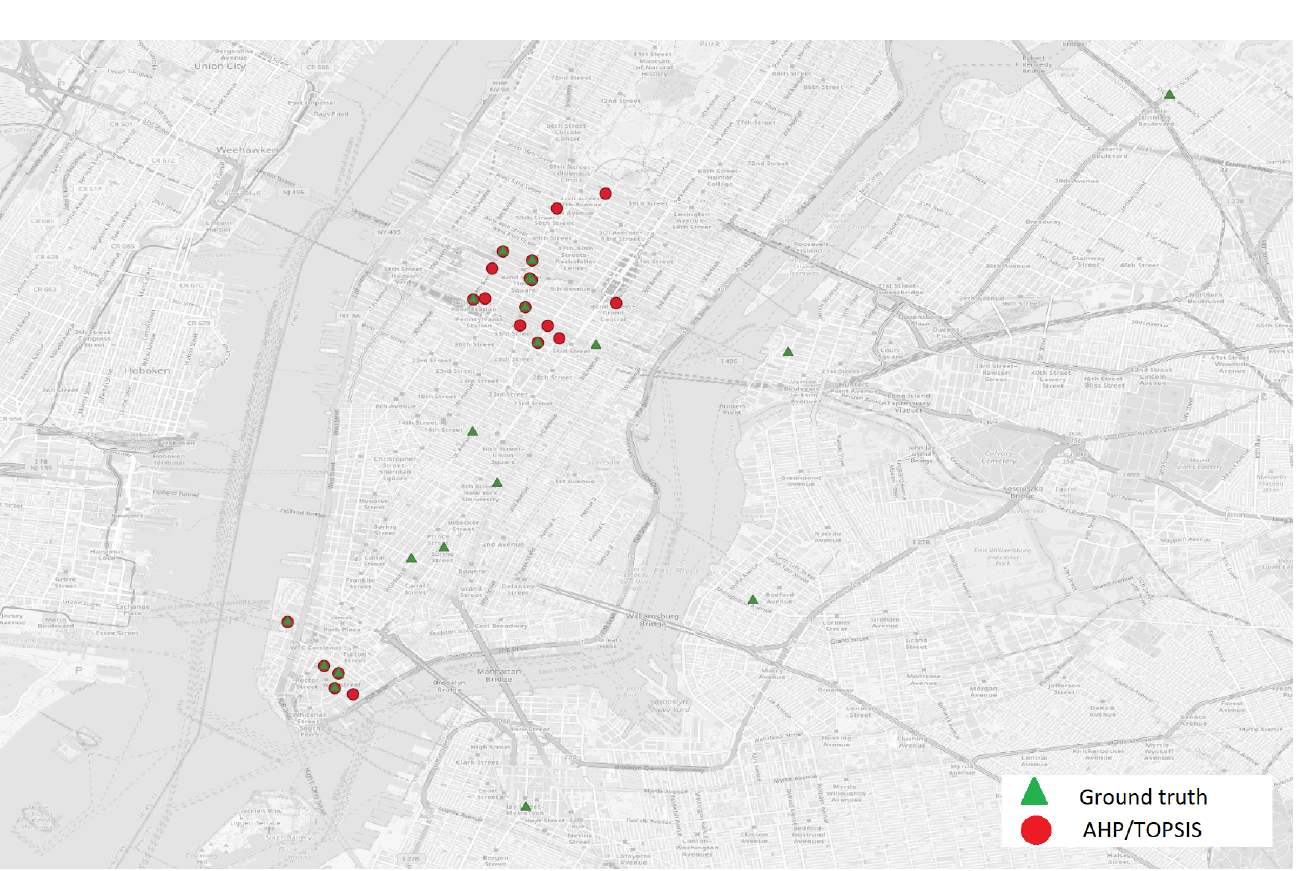
Figure 8. Convenience store placement: ground truth vs.